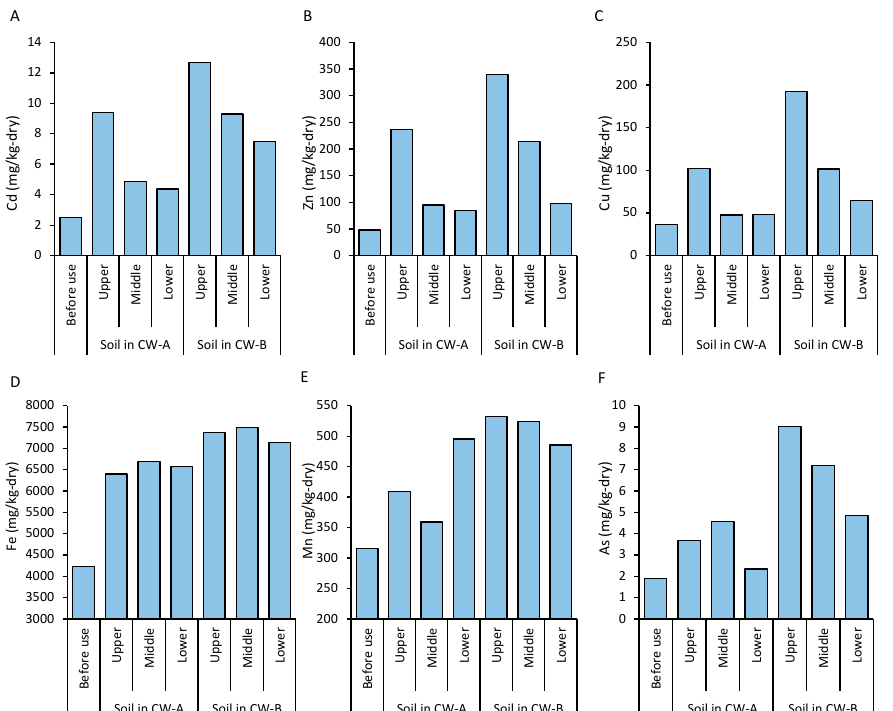
Figure 5. Metal contents in loamy soil in the unplanted CW (CW-A) and the cattail-planted CW (CW-B) before and after the NMD treatment experiment. Cd ( A ), Zn ( B ), Cu ( C ), Fe ( D ), Mn ( E ), and As ( F ).